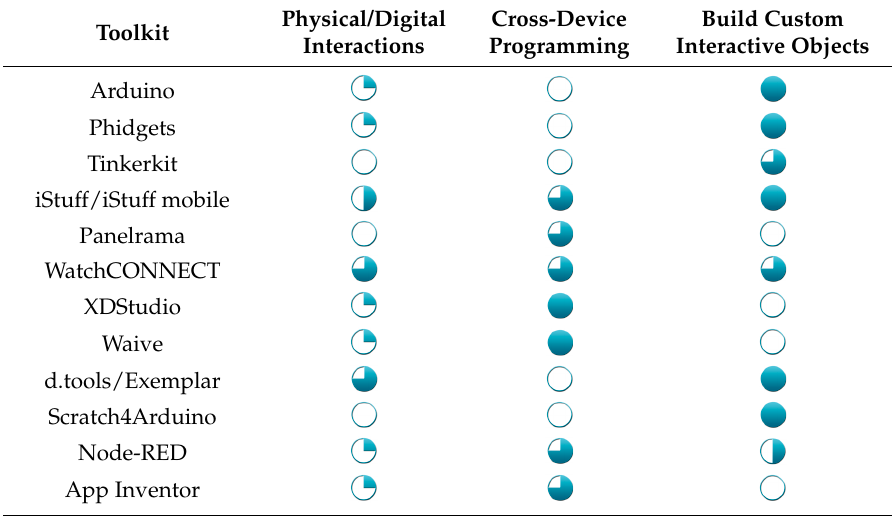
Table 1. Overview of the state of the art according to the challenges addressed by the ECCE toolkit. We used Harvey Balls ideograms to provide a qualitative evaluation, from meaning “no support”, to meaning “full support”.